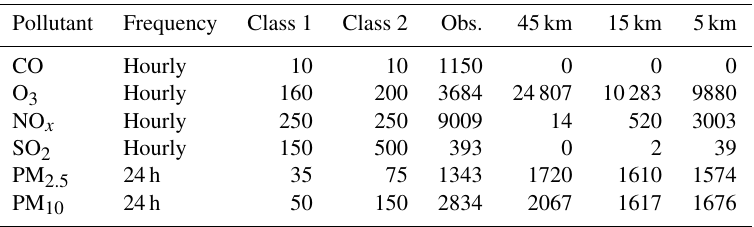
Table 2. Comparison of occurrences of exceedances of China’s national ambient air quality standards between observations (Obs.) and simulations.